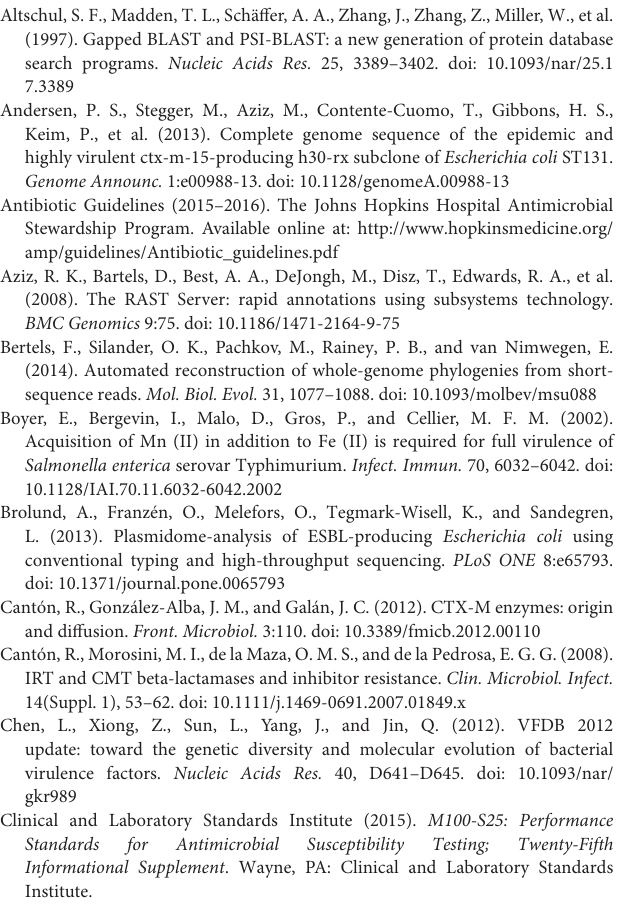
Supplementary Table 4 | Presence and absence of TA systems in the plasmid